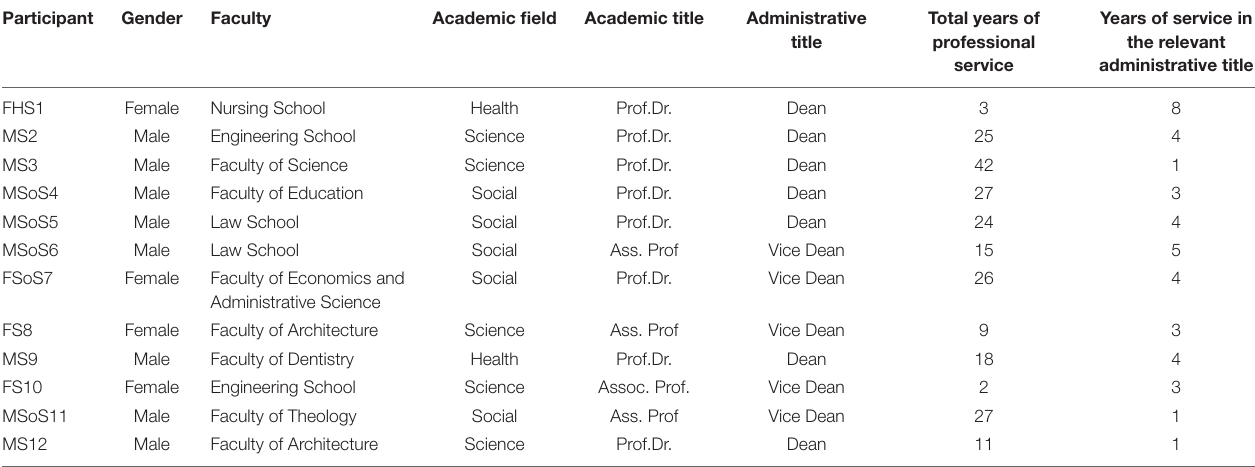
TABLE 1 | Personal information regarding the study